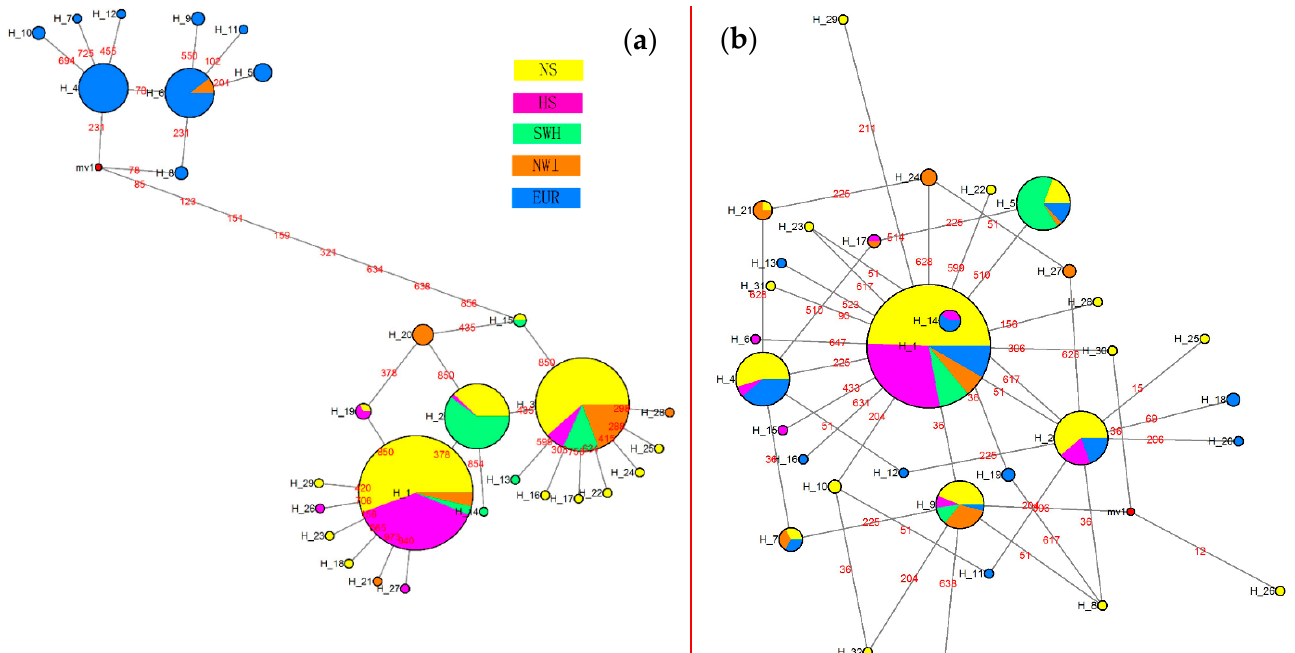
Figure 6. Haplotype network of R. padi in China and Europe countries. ( a ): The combined COI and COII genes, H_1 to H_29 represent HRp1 to HRp29; ( b ): the EF − 1 α gene, H_1 to H_32 represent HRp1 to HRp32. The area of the circles represents the number of individuals sharing the haplotypes. The red numbers indicate the nucleotide positions of polymorphic sites between two haplotypes. NS, north spring maize region in China; HS, Huanghuaihai summer maize region in China; SWH, southwest hilly maize region in China; NWI, northwest inland maize region in China; EUR, European countries maize region.